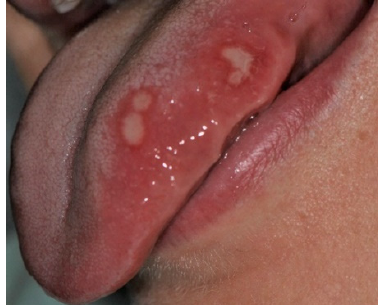
Figure 3. Minor aphthae on the left margin of the tongue in an adolescent boy. Four oval ulcerations with a yellowish-whitish removable fibrinopurulent membrane encircled by an erythematous halo.